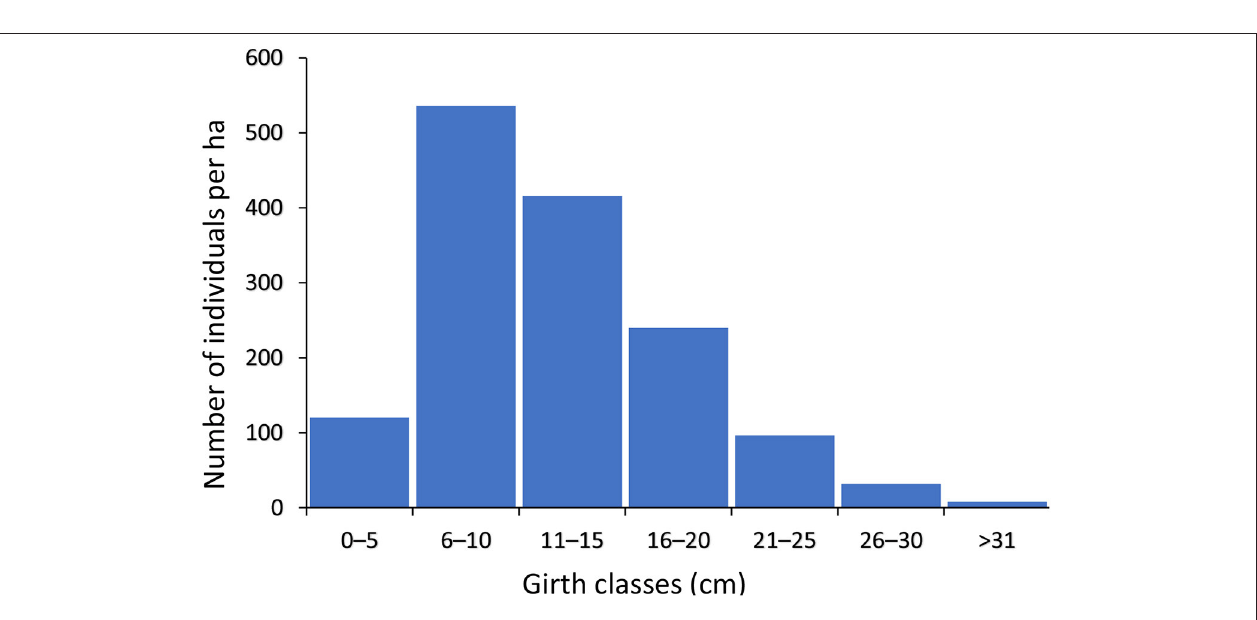
( Rhododendron arboretum ), oriental thuja ( Thuja orientalis ), Japanese cedar ( Cryptomeria japonica ), and A. dubia are